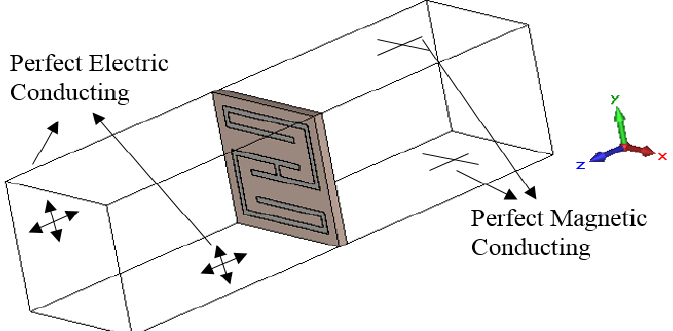
Figure 2. Simulation set-up for the metamaterial unit cell in the Computer Simulation Technology Microwave Studio (CST